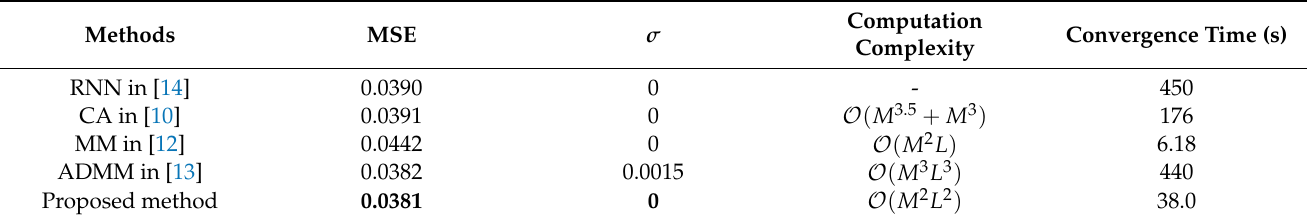
Table 2. The MSE, σ , computation complexity, and convergence time (seconds) for different methods when considering Case 2 as the desired beampattern.